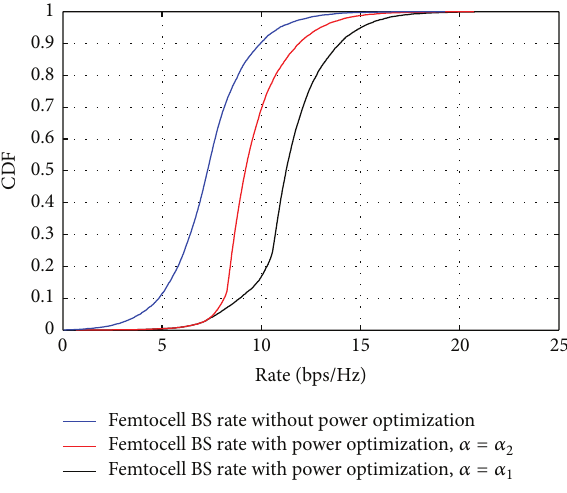
Figure 6: Femtocell BS rate